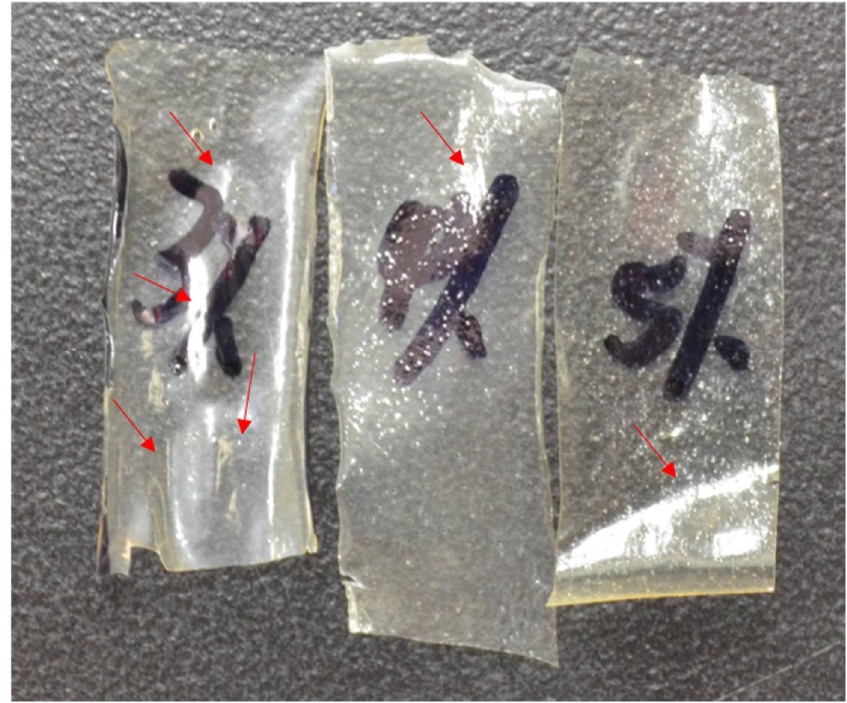
Figure 9. Picture for chitosan films after they were crosslinked and dried. The red arrows point to the wrinkles on the film.